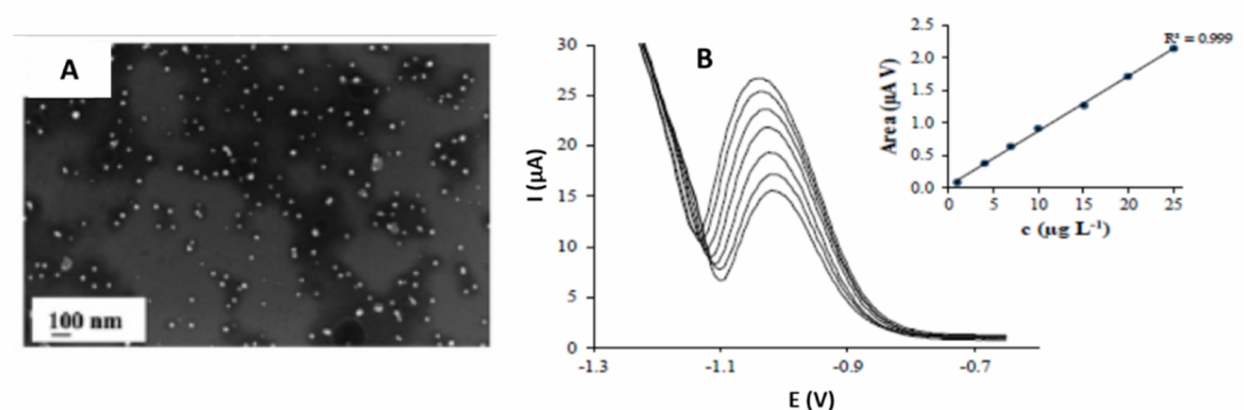
Figure 5. ( A ) SEM micrograph of AgNPr (800 µ L of Ag Seeds solution). ( B ) Differential pulse anodic stripping voltammo- grams of As(V) and its calibration plot in 0.01 mol L − 1 pH 2 applying − 1.30 V and a deposition time of 120 s. Reproduced with permission of Torres-Rivero et al., Nanomaterials; published by MDPI, 2020